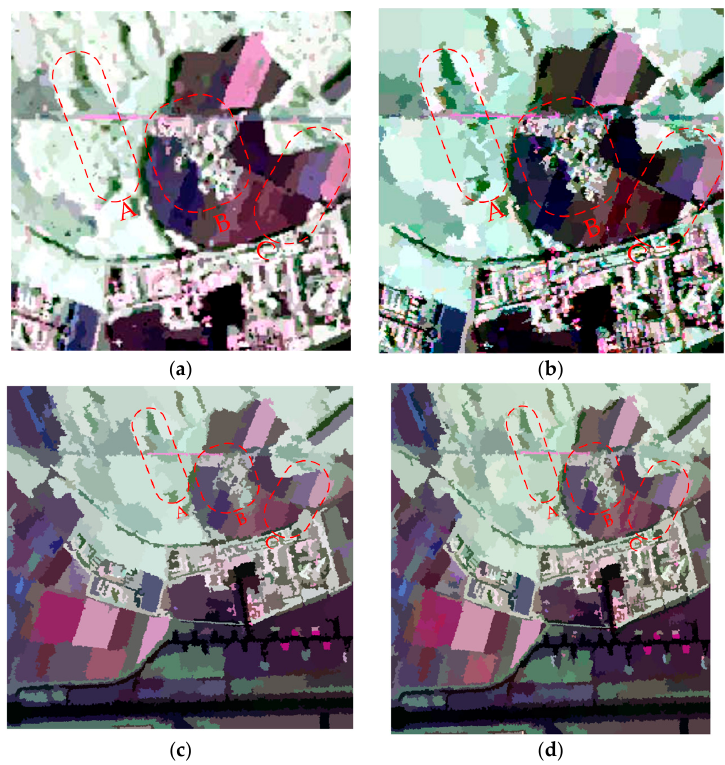
Figure 9. Representation maps (Pauli RGB images) of segmentation results for the ESAR data using different methods: ( a ) GSRM; ( b ) MW-WMRF; ( c ) IFGS, t = 17, w shp = 0.05, g 2 = 16; and ( d ) IFGS, t = 13, w shp = 0.05, g 2 =